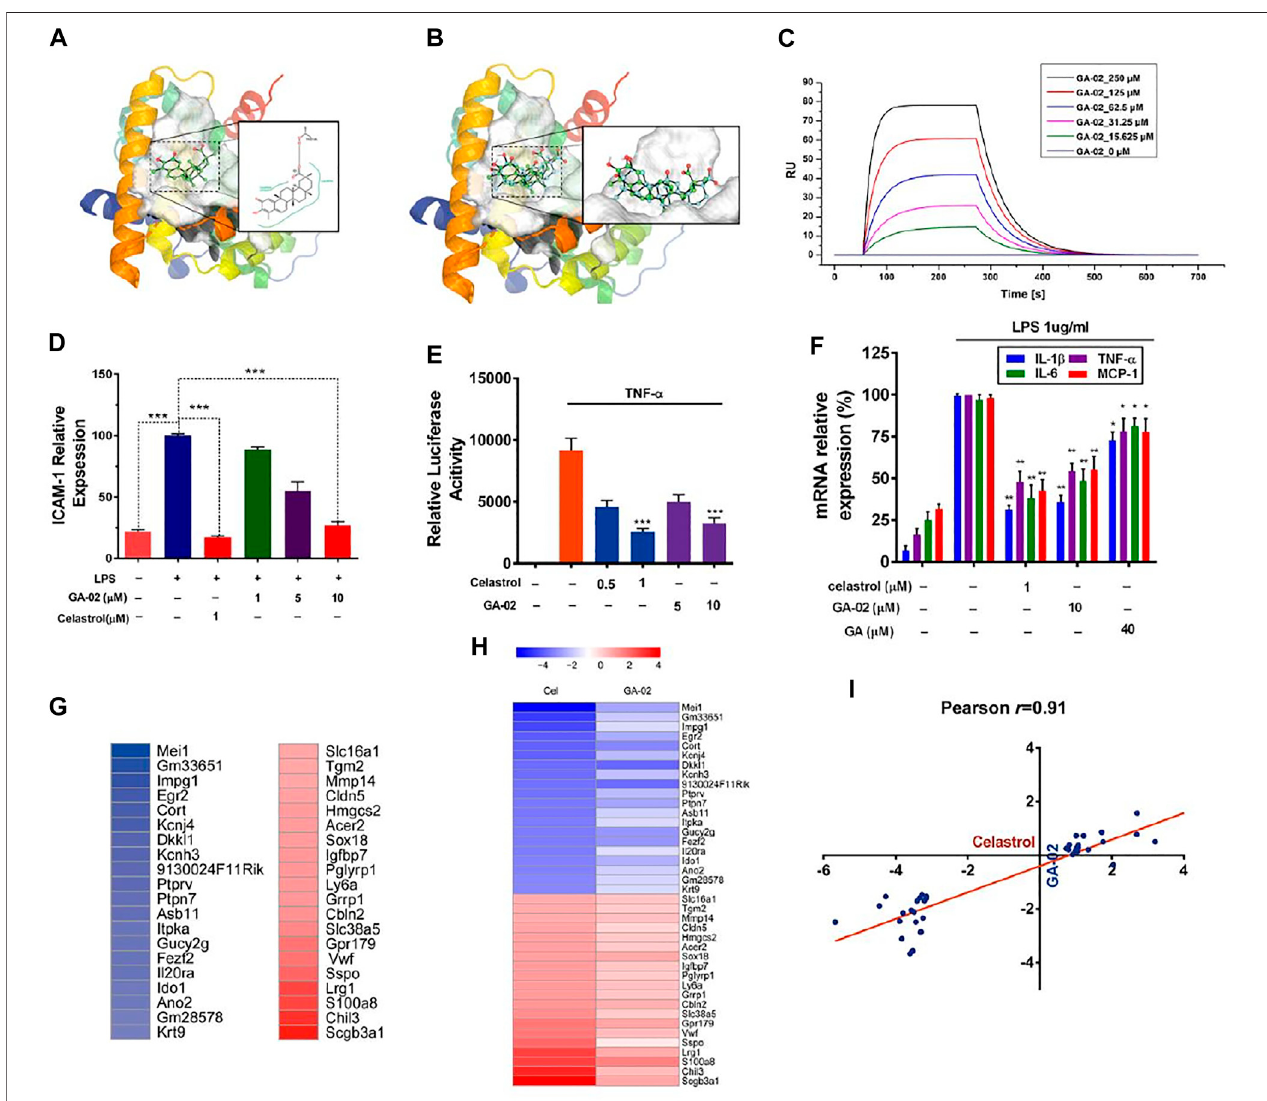
FIGURE2| GA-02mimicscelastrolinreceptorbindingandkeygeneexpression. (A) ThebindingmodeofGA-02(cyanball-and-stickmodel)withNur77generated byPoseView.Nur77 (PDB code4JGV) isshown asribbon diagram, and GA-02 asgreen ball-and-stickmodel. (B) Thevan der Waalssurface ofsuperimposed